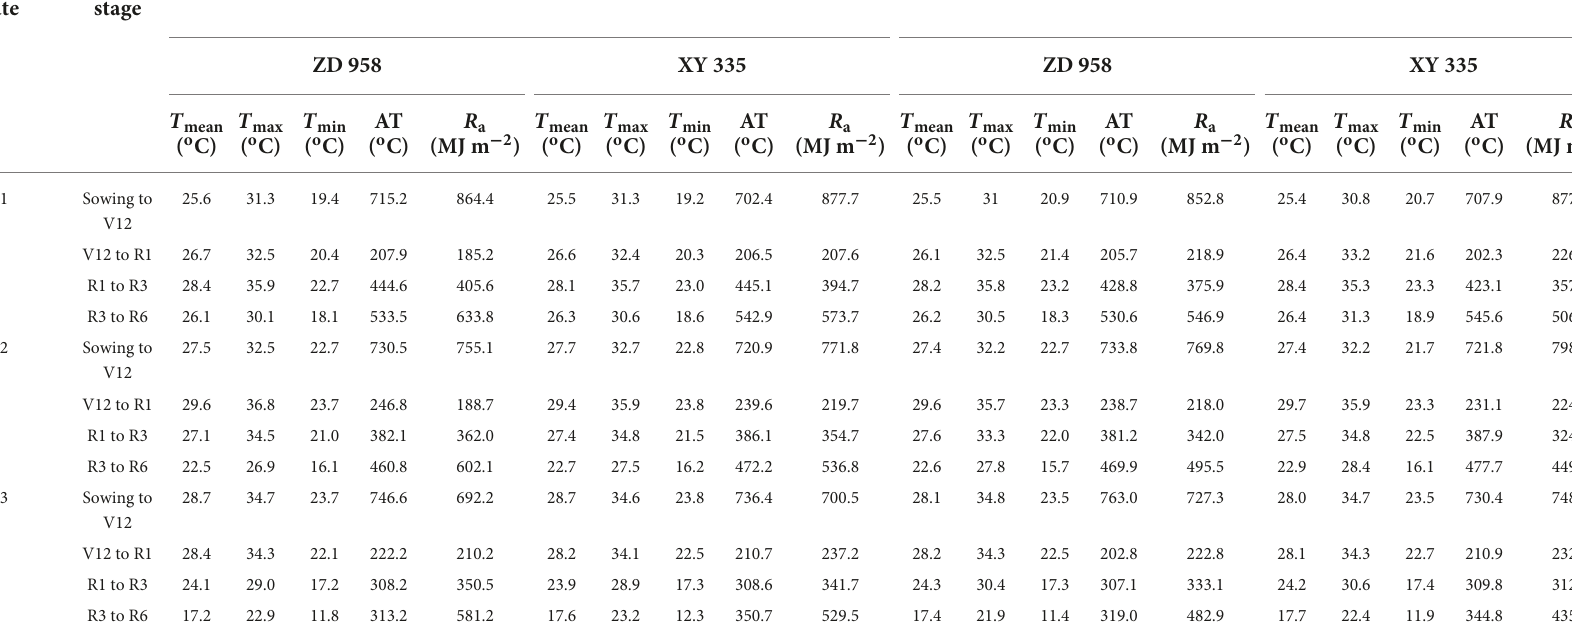
TABLE 1 Daily mean temperature ( T mean ), maximum temperature ( T max ), daily minimum temperature ( T min ), effective accumulated temperature (AT), and accumulated radiation ( R a ), during the maize growth stage in 2019 and 2020. Sowing Growth date